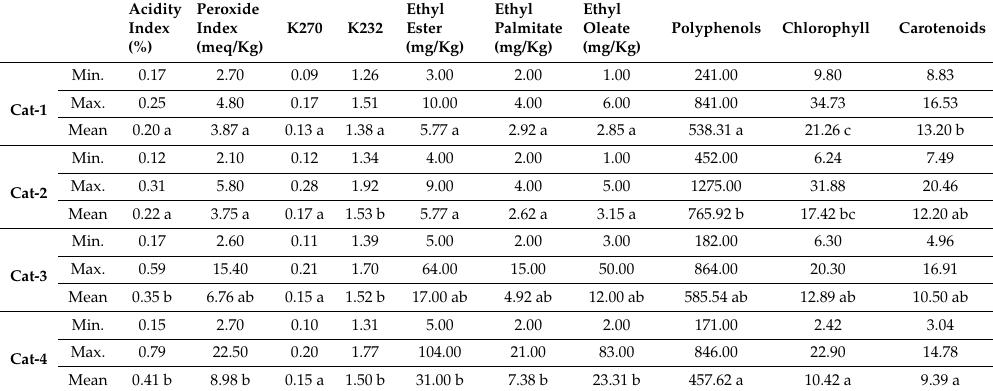
Table 1. Minimum, maximum and mean values for each chemical parameter. Statistical differences (Tuckey’s, p ≤ 0.05) are denoted by different letters in the mean